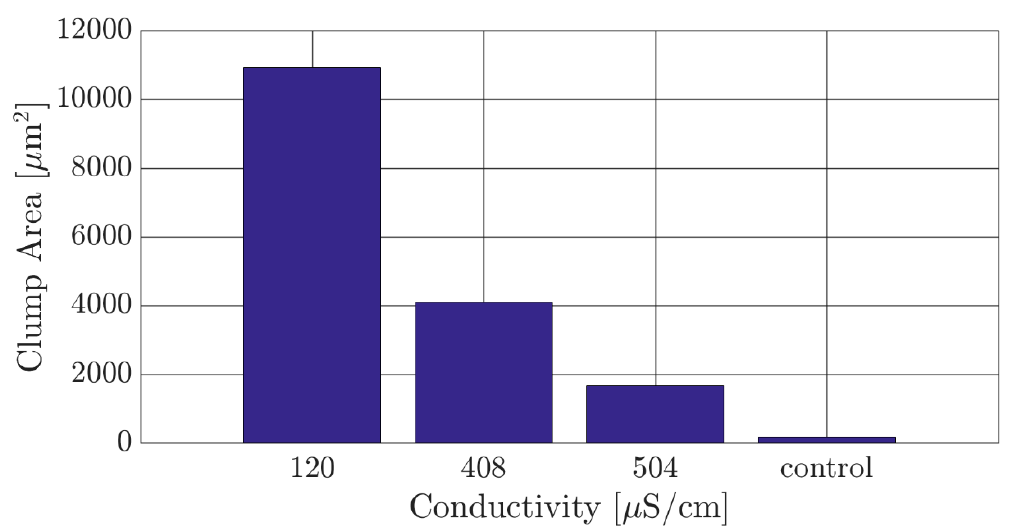
Figure 2. The total clump area of Trypanosoma brucei measured in different samples featuring a standard dielectrophoresis (DEP) experimental medium (120 µS/cm) and in experimental media with increasing electrical conductivity. The control was a sample of T. brucei in their standard culture media. An experimental medium with electrical conductivity of 504 µS/cm was chosen as a compromise between maintaining a suspension of individual parasites and a conductivity value that can lead to a strong positive DEP response.